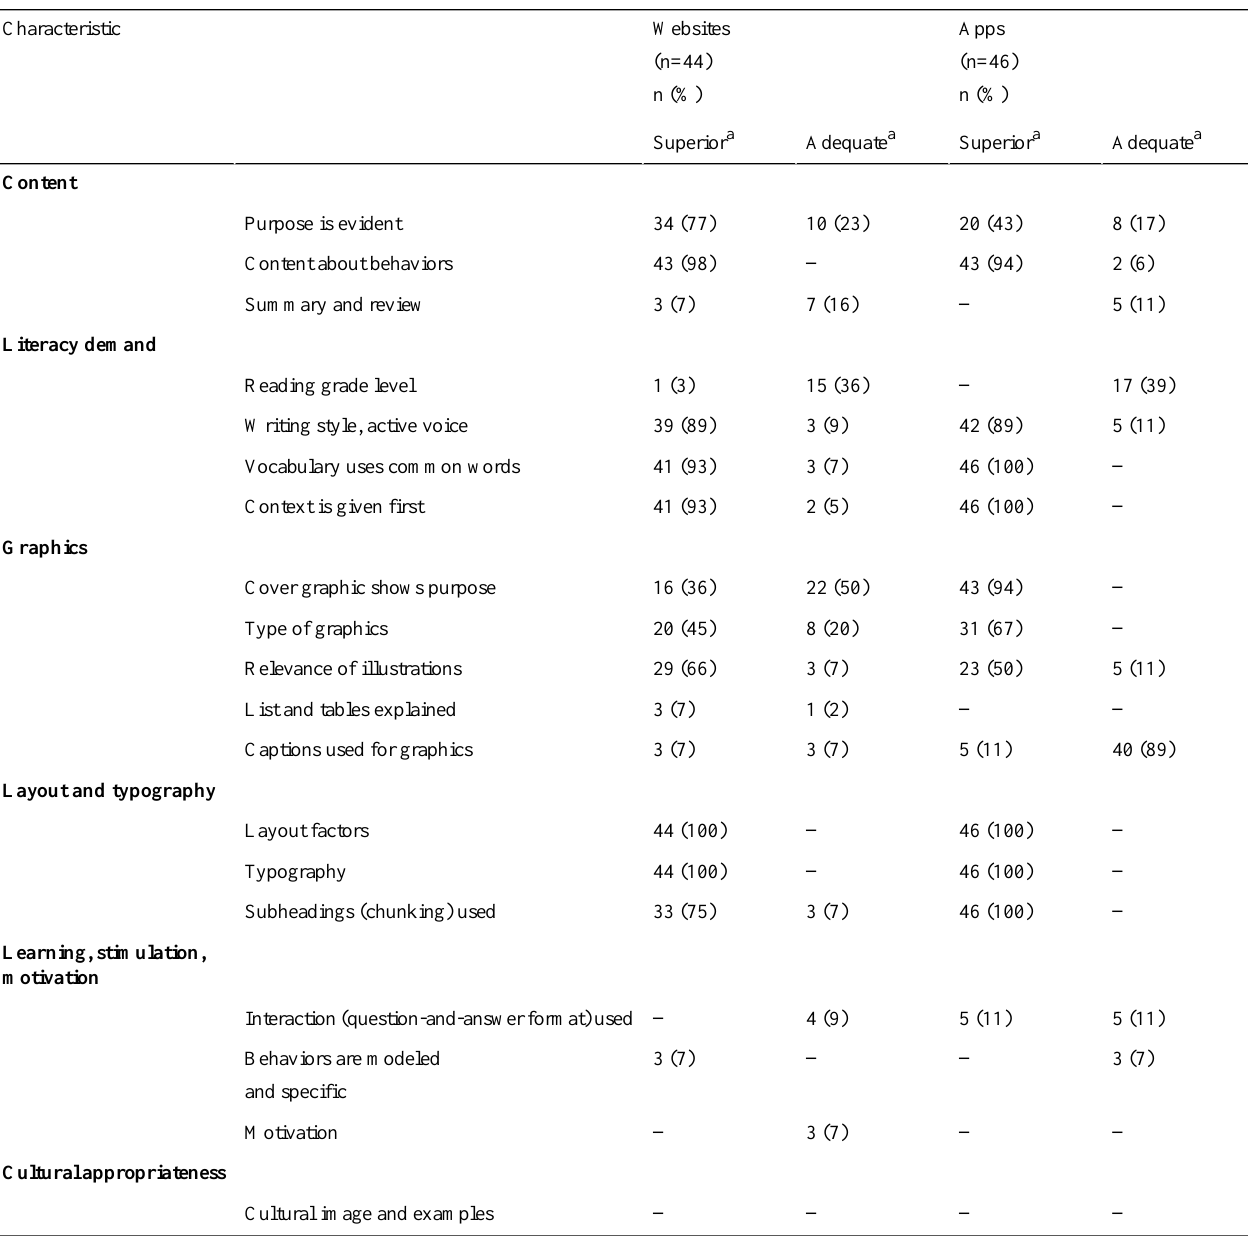
Table 1. Infant feeding website and app scores using the SAM criteria.